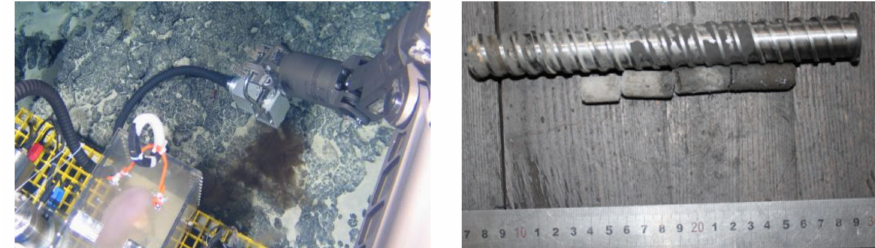
Figure 15. Deep-sea drilling operation and core collected from a cobalt crust on the